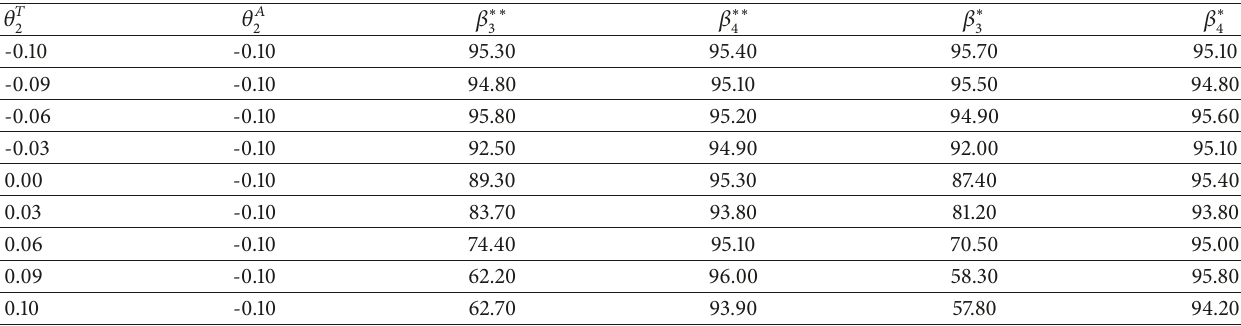
Table 2: CI coverage for the estimated 𝛽 3 and 𝛽 4 in percent at assumed 𝜃 2 =-0.10. We use 𝜃 𝑇 2 for the true 𝜃 2 , 𝜃 𝐴 2 for the assumed value in adjusting the estimates, ( 𝛽 ∗∗ 3 , 𝛽 ∗∗ 4 ) for the Copas and Eguchi adjustment method, and ( 𝛽 ∗ 3 , 𝛽 ∗ 4 ) for the least false adjustment method. Results based on 1000 samples of size